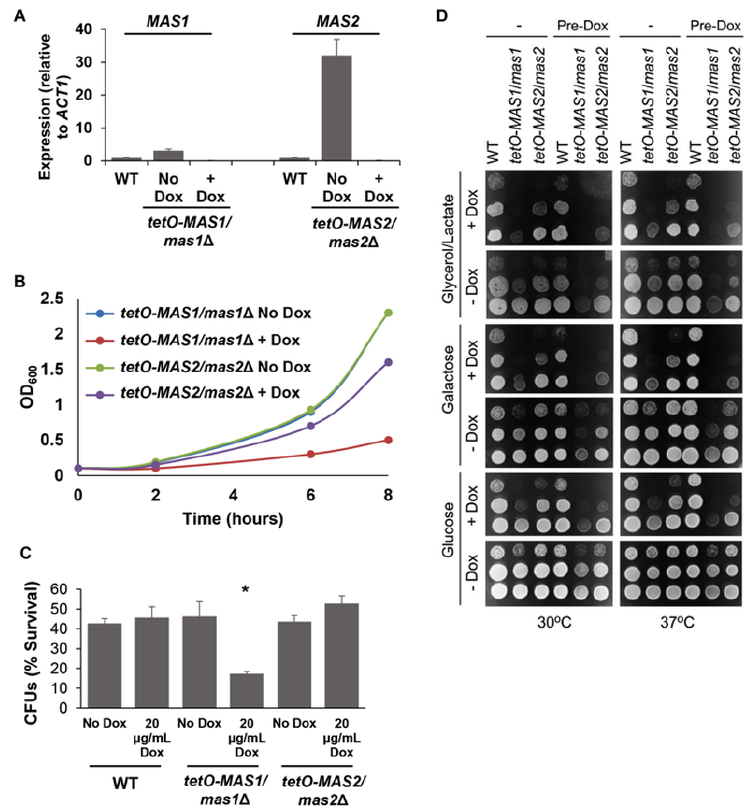
FIGURE 6: The MPP Mas1 and Mas2 are required for mitochondrial function. (A) Assessment of the conditional mutants for MAS1 and MAS2 . MAS1 and MAS2 are depleted using the tetracycline repressi- ble promoter. C. albicans wild-type (WT), tetO- MAS1/mas1 D and tetO-MAS2/mas2 D cells were grown in the absence (No Dox) or presence (+ Dox) of 20 µg/ml doxycycline for 24 hours and then sub- cultured in the same conditions for 6 hours; tran- script levels of MAS1 and MAS2 were measured and normalised to the ACT1 loading control. (B) Deple- tion of MAS1 or MAS2 reduces C. albicans growth. The tetO-MAS1/mas1 D and tetO-MAS2/mas2 D strains were grown in the absence (No Dox) or presence (+ Dox) of 20 µg/ml doxycycline for 24 hours, before being subcultured under the same conditions. Growth was measured for a further 8 hours and OD 600 was plotted against strains in the absence of depletion. (C) Mas1 is required for oxi- dative stress survival. The impact of oxidative stress on the tetO-MAS1/mas1 Δ and tetO-MAS2/mas2 Δ strains and the respective wild type was deter- mined by measurement of CFUs after a 1 hour stress with 5 mM H 2 O 2 . Percent CFUs was deter- mined relative to untreated cells. Students